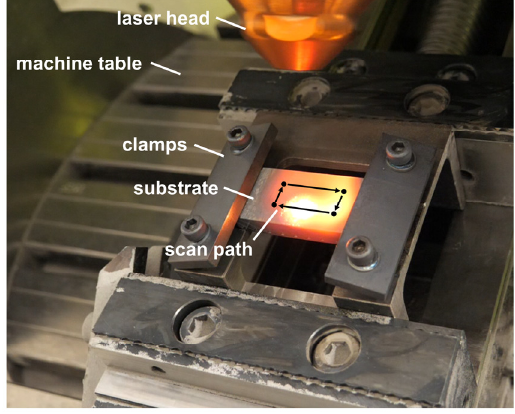
Figure 2. Experimental setup for the laser preheating process.